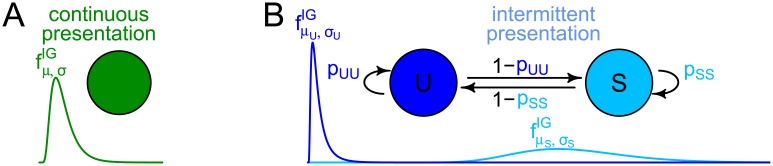
A simple HMM for bistable perception.(A) One state describes a unimodal distribution of dominance times under continuous presentation. (B) Two states (stable, S, and unstable, U) produce long and short dominance times under intermittent presentation.